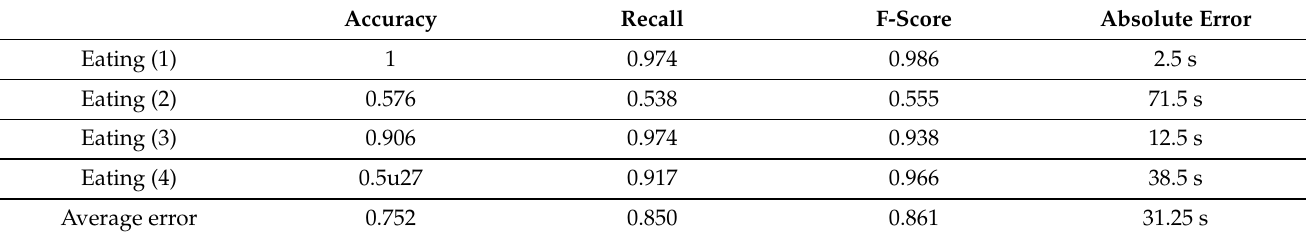
Table 5. F-score comparison between real and simulated eating activities on 4 November 2010.